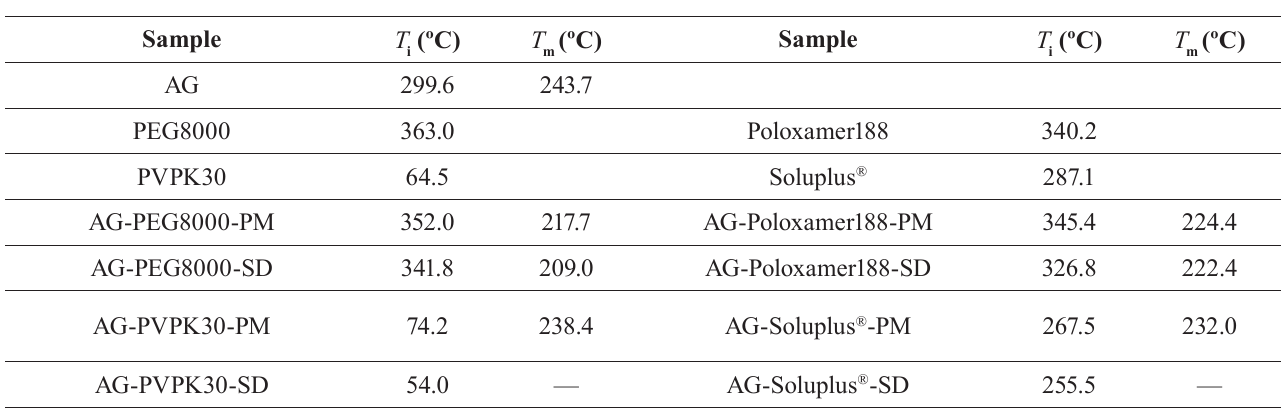
TABLE II - T and T of pure AG, carrier material, PM and i m